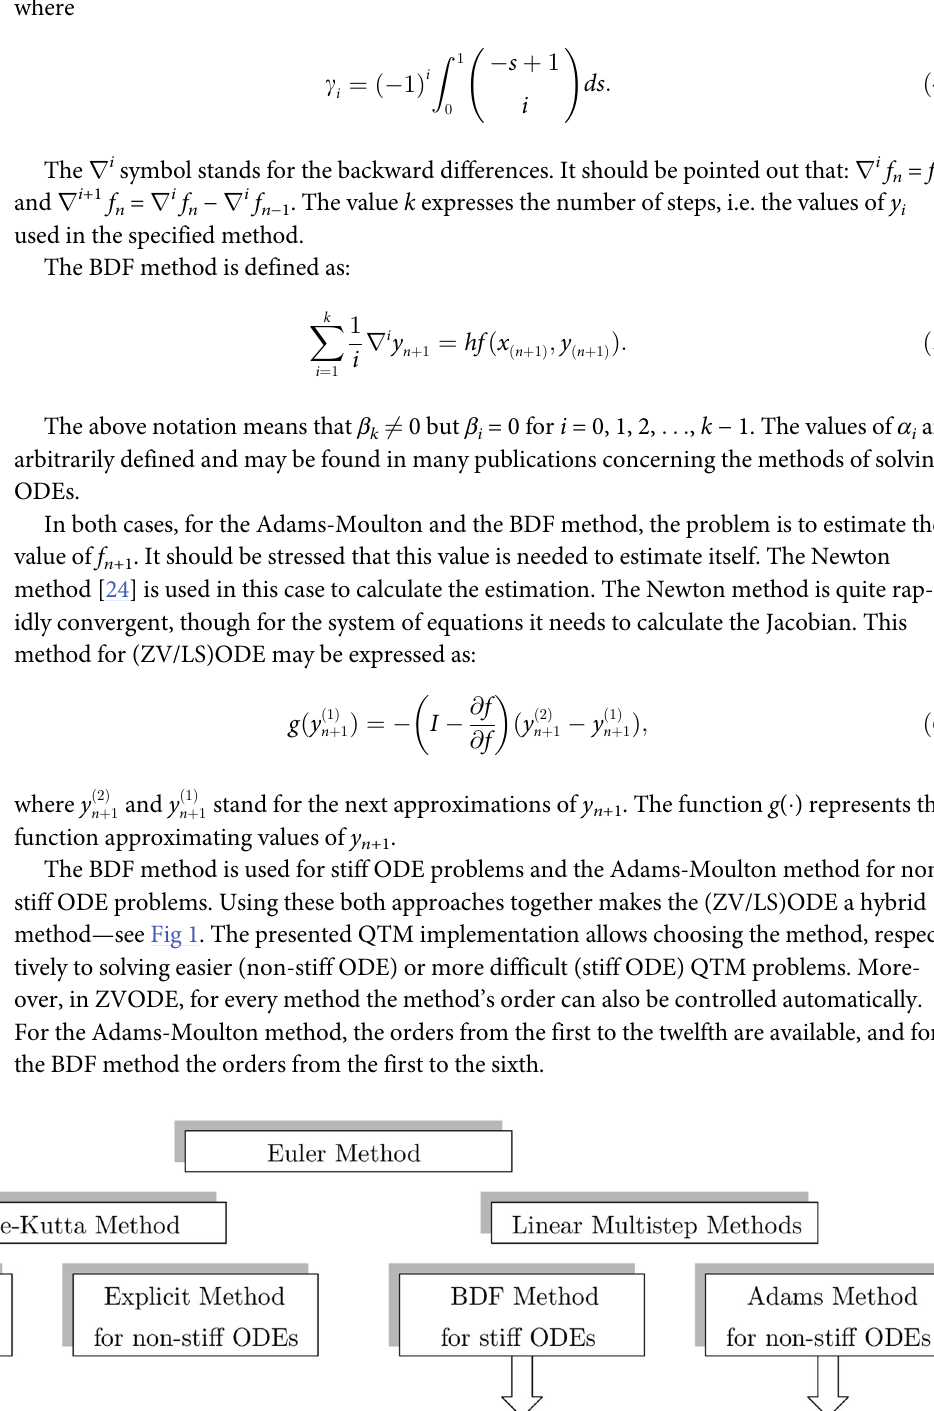
PLOS ONE | https://doi.org/10.1371/journal.pone.0208263 December10,